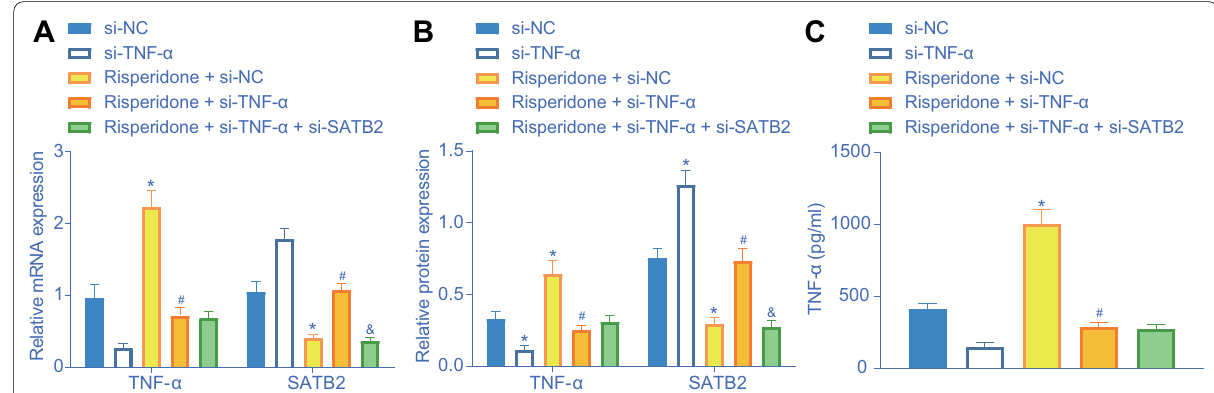
Fig. 7 Risperidone promotes TNF-α expression to inhibit SATB2 expression in vivo . A, the mRNA expression of TNF-α and SATB2 in femur tissues of mice determined by RT-qPCR. B, Western blot analysis of TNF-α and SATB2 expression in femur tissues of mice. The band intensity was quantified. C, the expression of TNF-α in the serum of mice was evaluated by ELISA. * p < 0.05, compared with mice introduced with lentivirus expressing si-NC. # p < 0.05, compared with mice introduced with cRisperidone lentivirus expressing si-NC. & p < 0.05, compared with mice introduced with + Risperidone lentivirus expressing si-TNF-α. The experiments are repeated 3 times n + =